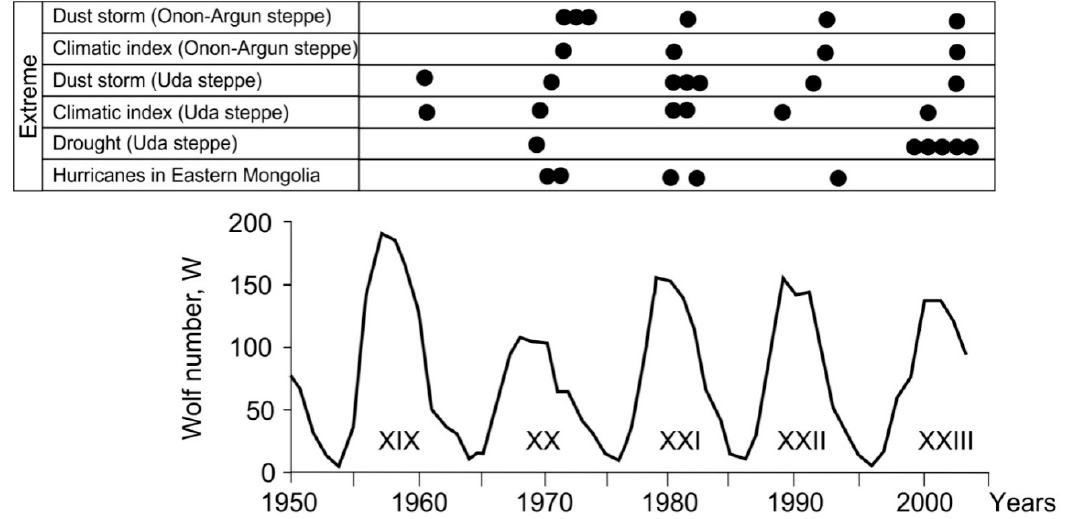
Figure 10. Location of extreme events of aeolian processes relative to solar activity cycles (XIX—XXIII). C—climatic indicator of deflation; DS—dust storms. Hurricanes (Eastern Mongolia) are given according V.P. Chichagov (1998).